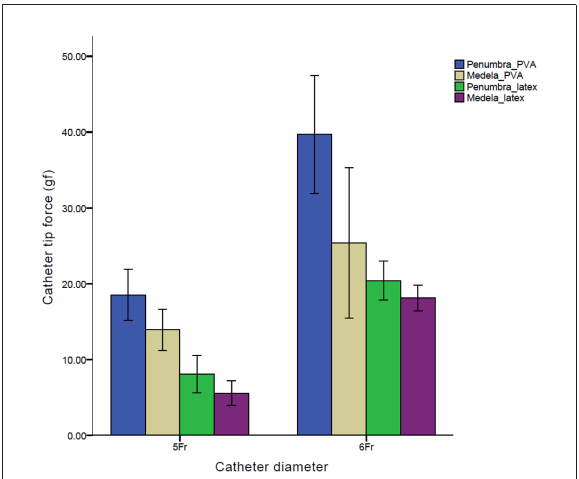
FIGURE4 Comparison of catheter tip forces of the 5Fr Sofia and 6Fr Sofia Plus catheters combined with the Penumbra Jet Engine and Stryker Medela AXS Universal Aspiration